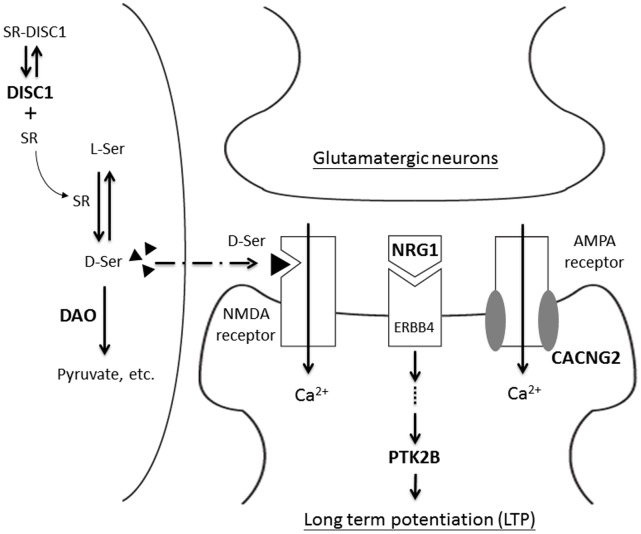
A schematic diagram to show the relation among genes that involved in the observed gene-gene interactions.The top, bottom, and left side components represent the pre-synaptic neuron, post-synaptic neuron, and glial cells, respectively. Three types of receptors (NMDA receptor, ERBB4 receptor, and AMPA receptor) are drawn on the post-synaptic neuron. All the genes involved in the gene-gene interactions are shown in boldface. NRG1 is the ligand for ERBB4 receptor, which may trigger the long term potentiation by way of the PTK2B protein activation. DISC1 may stabilize serine racemase (SR), which will convert L-Serine to d-Serine (d-Ser). The black triangle on the side of NMDA receptor represents d-Ser, which is a co-agonist of this receptor. Both NMDA and AMPA receptors are calcium channels, which may increase calcium influx upon activation. Two molecules of CACNG2 (shown by the grey oval) were found on each AMPA receptor. Even though CACNG2 is a subunit of AMPA receptor, this protein is explicitly drawn in order to show its role in gene-gene interaction.